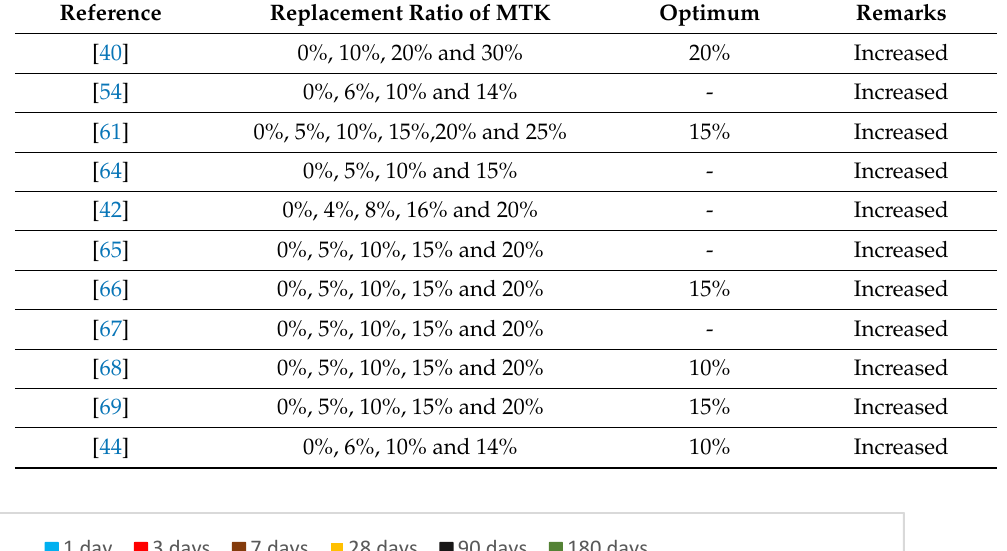
Table 4. Summary of Flexural Strength of Concrete.